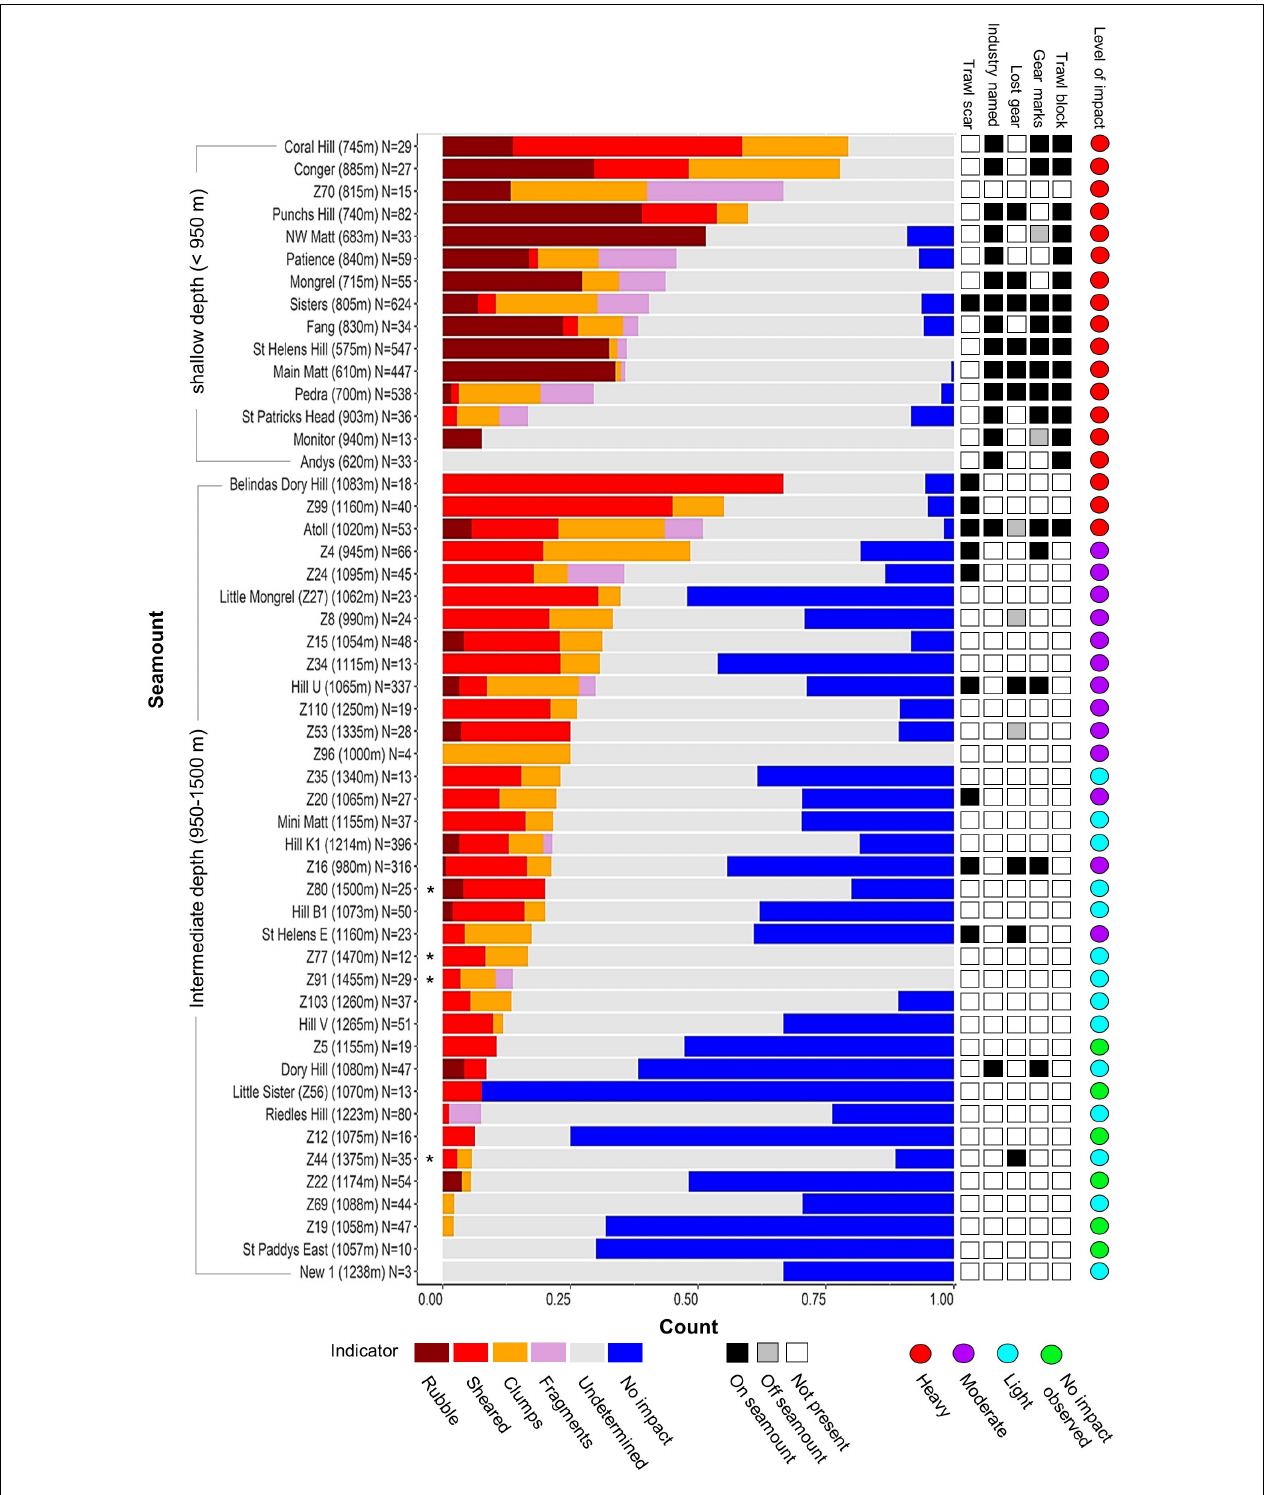
FIGURE 7 | Proportions of impact indicators ( Table 2 ) used to classify the “level of impact” on individual seamounts. Histogram shows proportions of numeric indicators sorted by combined proportion of impact indicators for shallow and intermediate depth seamounts separately; shallow and intermediate depth seamounts distinguished by the core depth range (950–1,350 m) of the dominant scleractinian coral ( Solenosmilia variabilis ); an asterix identifies deep seamounts > 1,350 m. Side bar shows the presence-only indicators – including seamount membership of blocks of high trawl effort and those named by the fishing industry).